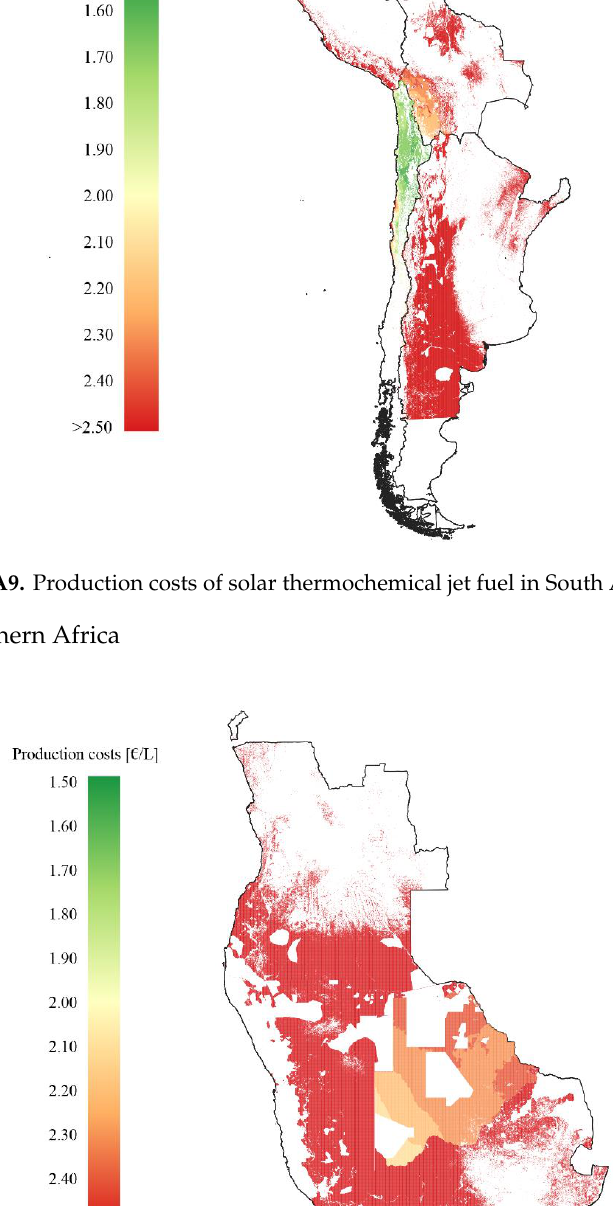
Figure A8. Production costs of solar thermochemical jet fuel in Australia.